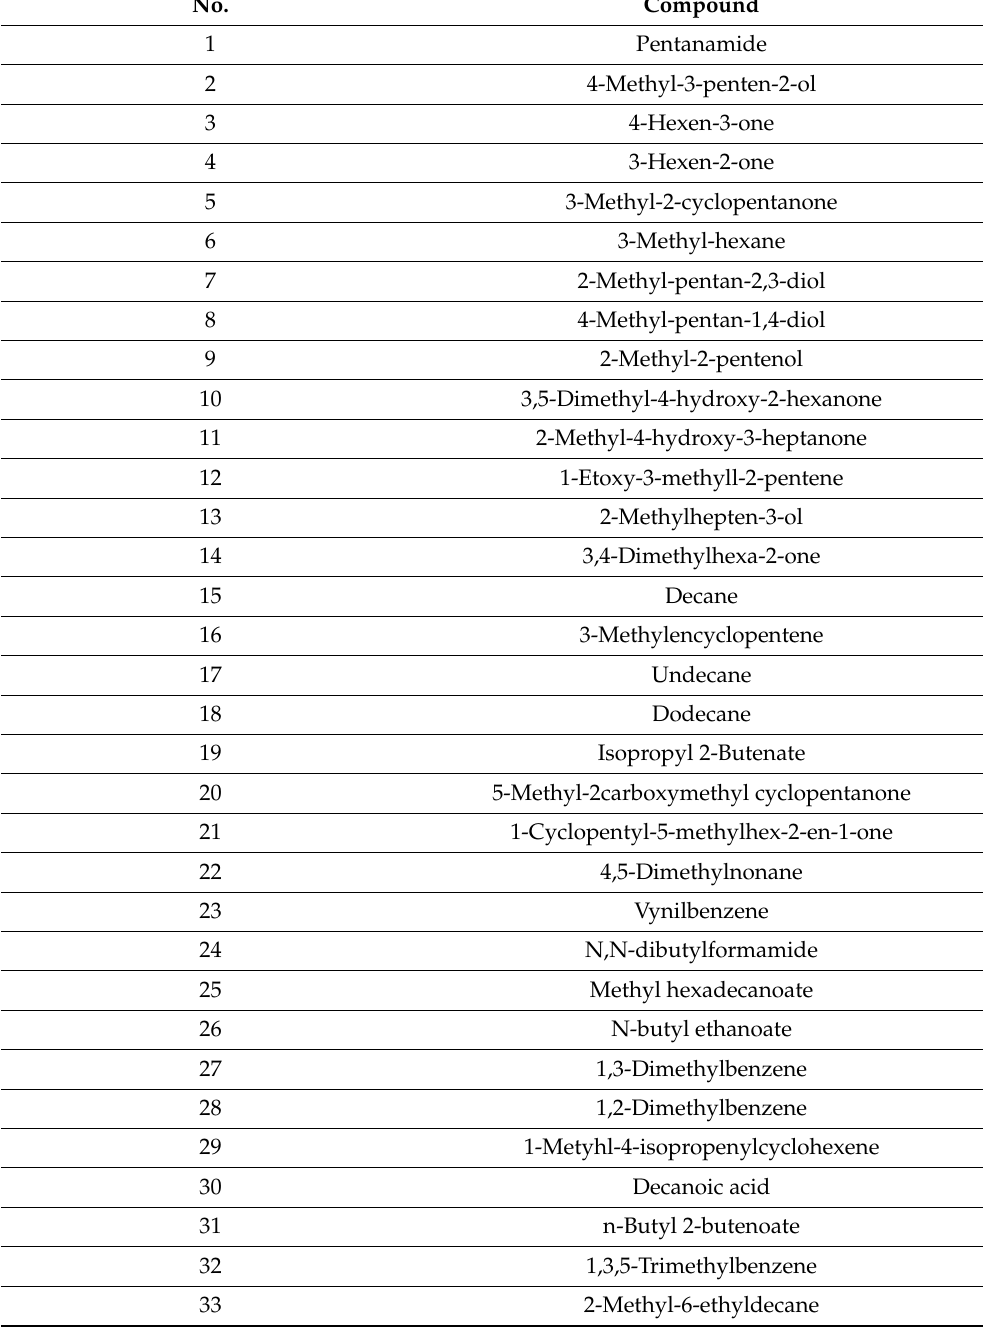
Table 3. Compounds identified by GC-MS from the culture of calluses of I. sonorae . No. Compound